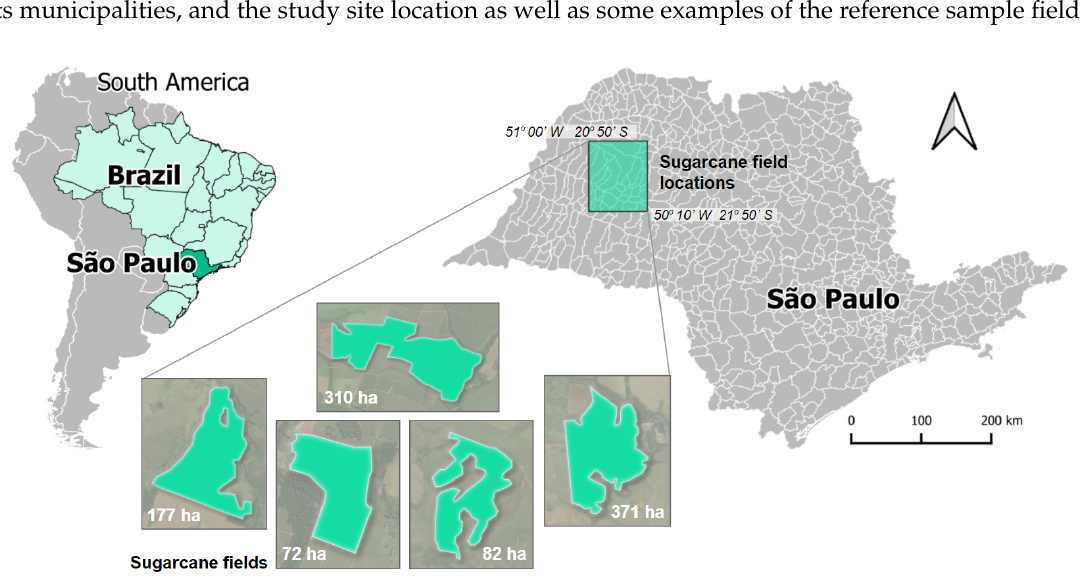
Figure 1. Location of the study area in the state of São Paulo